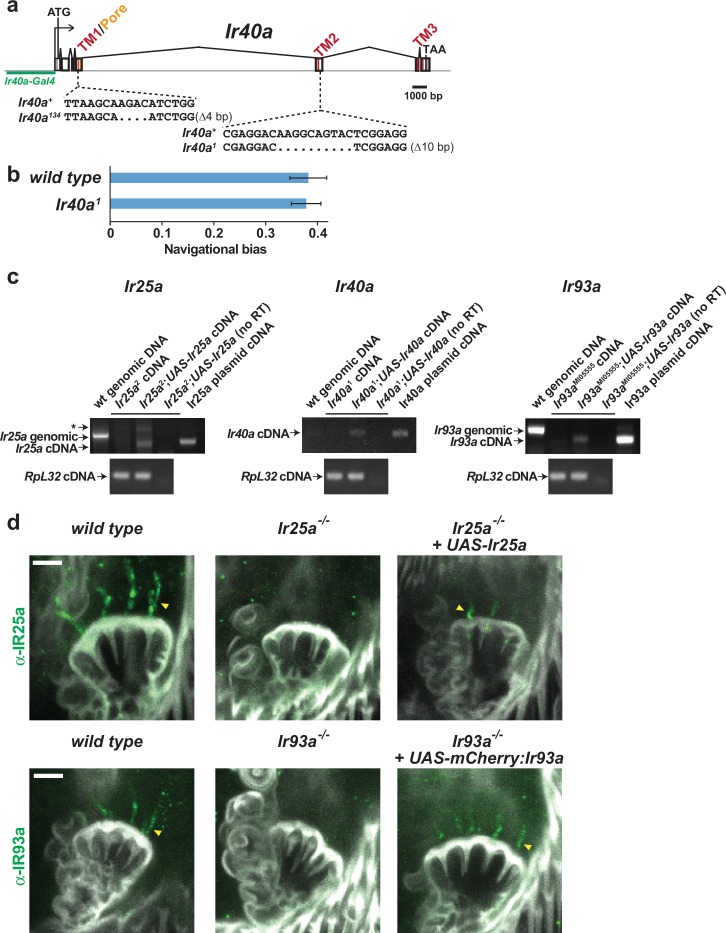
Description of Ir40a mutants and analysis of Gal4-independent transgene expression.(a) Gene structure and sequence alterations in Ir40a alleles. Regions encoding transmembrane domains (TMs) and pore region are in red. The Ir40a promoter region present in Ir40a-Gal4 is indicated in green. (b) Larval cool avoidance behavior (assayed as in Figure 1d) is unaffected by mutation of Ir40a. wild type, n = 37 animals. Ir40a1, n = 55. (c) RT-PCR analysis of Gal4-independent expression of UAS-Ir transgenes in adult heads in the indicated genotypes. Upper panels, IR-specific RT-PCR products. Lower panels: RpL32 (a ribosomal protein gene) as a cDNA synthesis control. Asterisk indicates a background amplification product observed in some Ir25a PCR reactions. The mechanism underlying Gal4-independent UAS-transgene expression is unknown, but is a phenomenon that has been previously reported (Mao et al., 2014). (d) Top: IR25a protein expression in the sacculus of wild-type, Ir25a2 and Ir25a2;UAS-Ir25a animals. Bottom: IR93a protein expression in the sacculus of wild-type, Ir93aMI05555 and Ir93aMI05555;UAS-mCherry:IR93a animals. Gal4-independent expression of UAS transgenes restores expression of IR25a and IR93a in the dendrites of sacculus neurons (arrowhead).